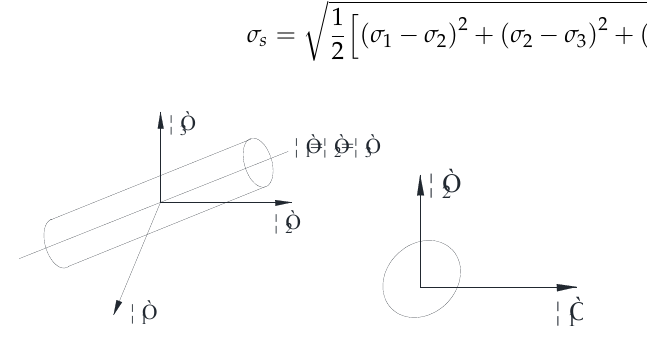
Figure 5. Schematic diagram of Miss yield criterion.